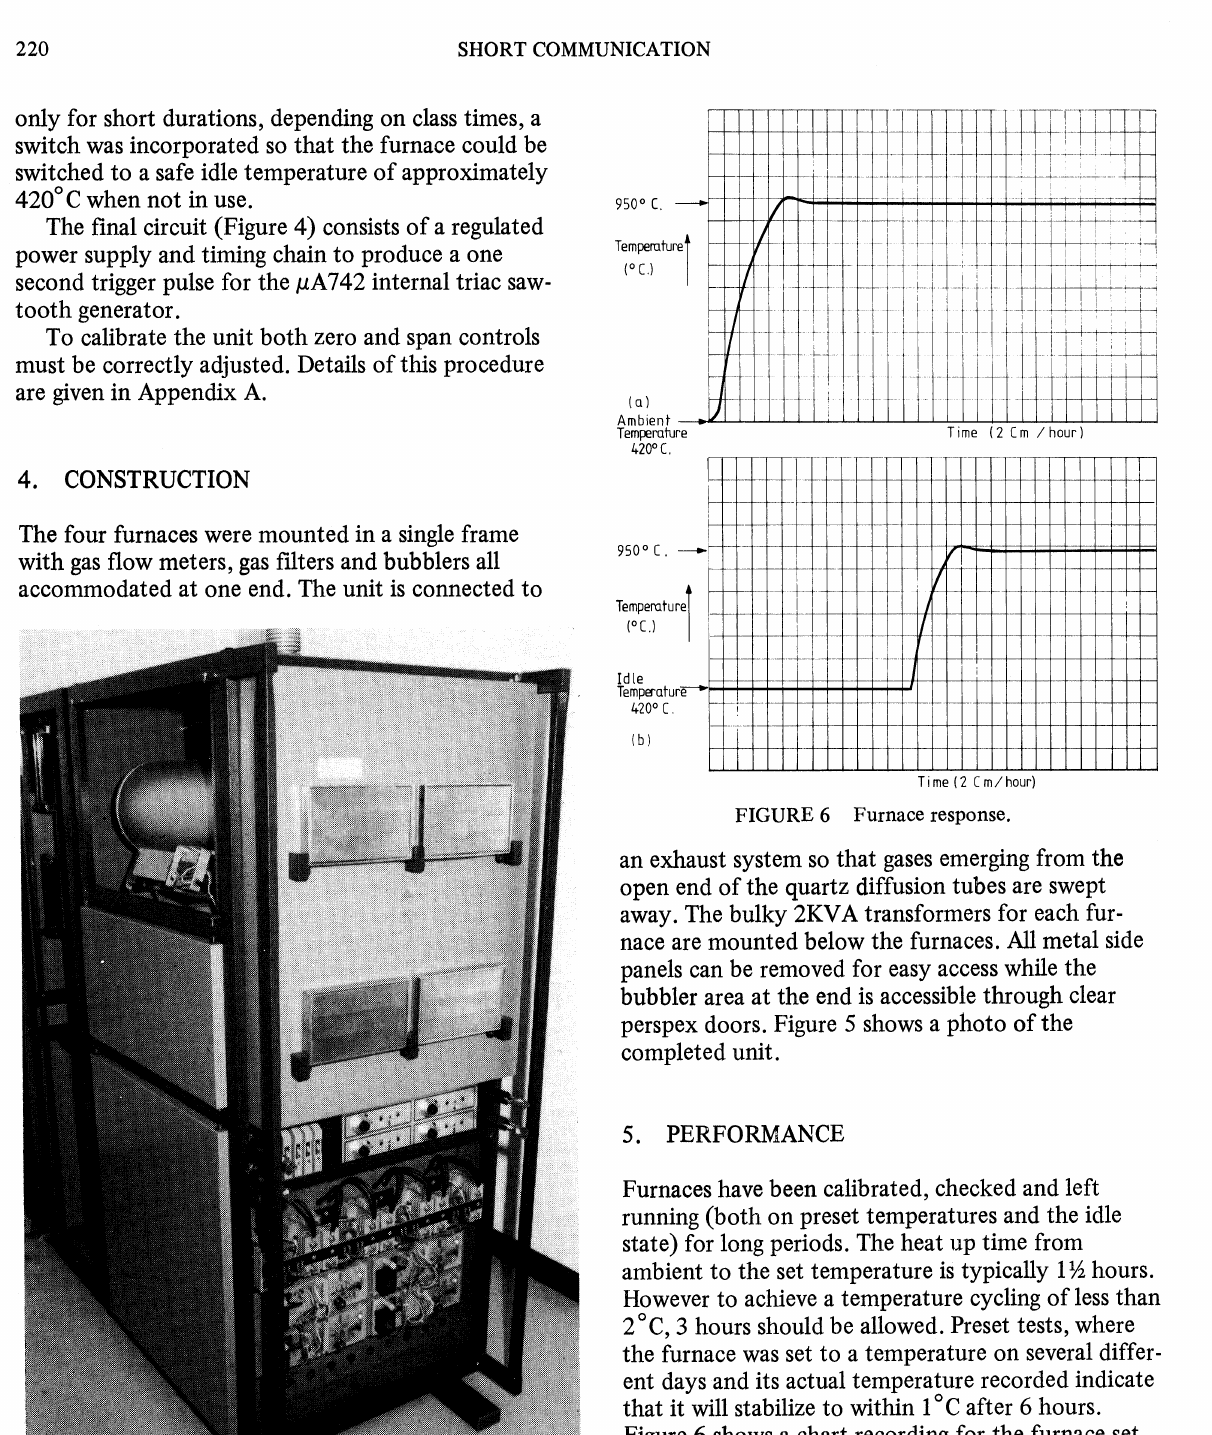
Furnace construction.